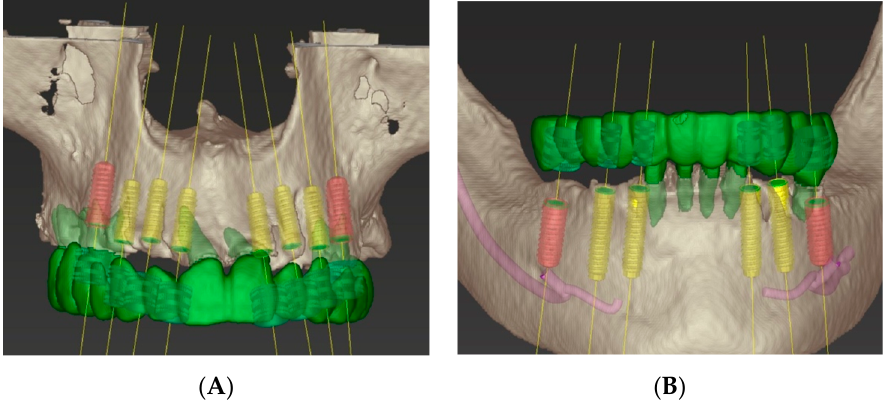
Figure 3. Computer-guided virtual planning. ( A ) Maxillary arch. ( B ) Mandibular arch.